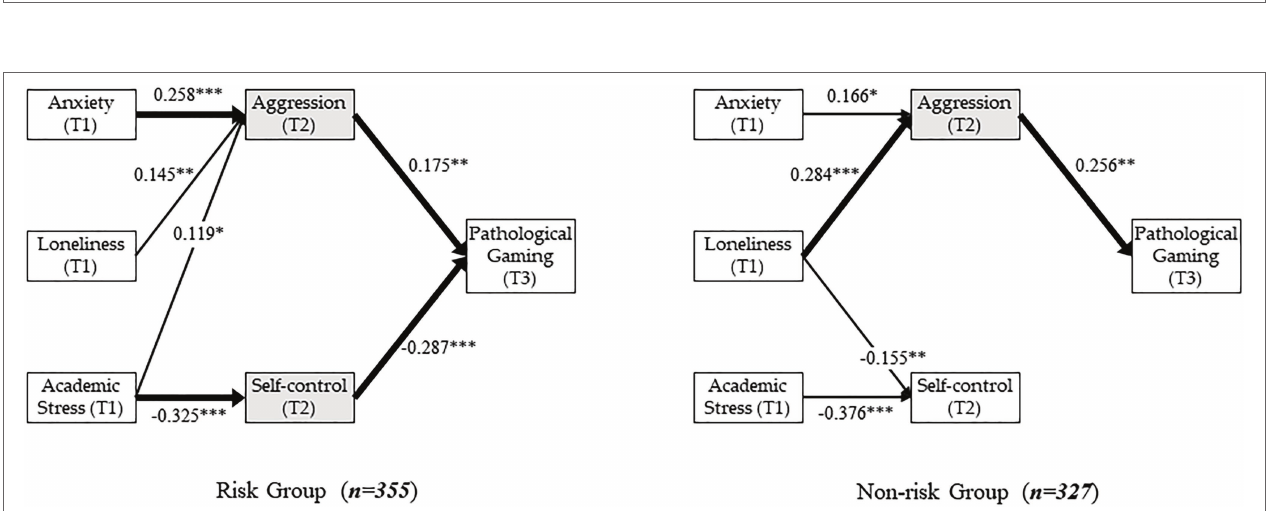
FIGURE 1 | Results of the latent class analysis of pathological gaming. As pathological gaming is measured on a scale of 100 points, the score of 50 is assumed to be the splitting point of the addiction risk tendency. Dotted line connects the measured values of the pathological gaming variables from waves 1–3, and the bold and solid line reflects the trend line.